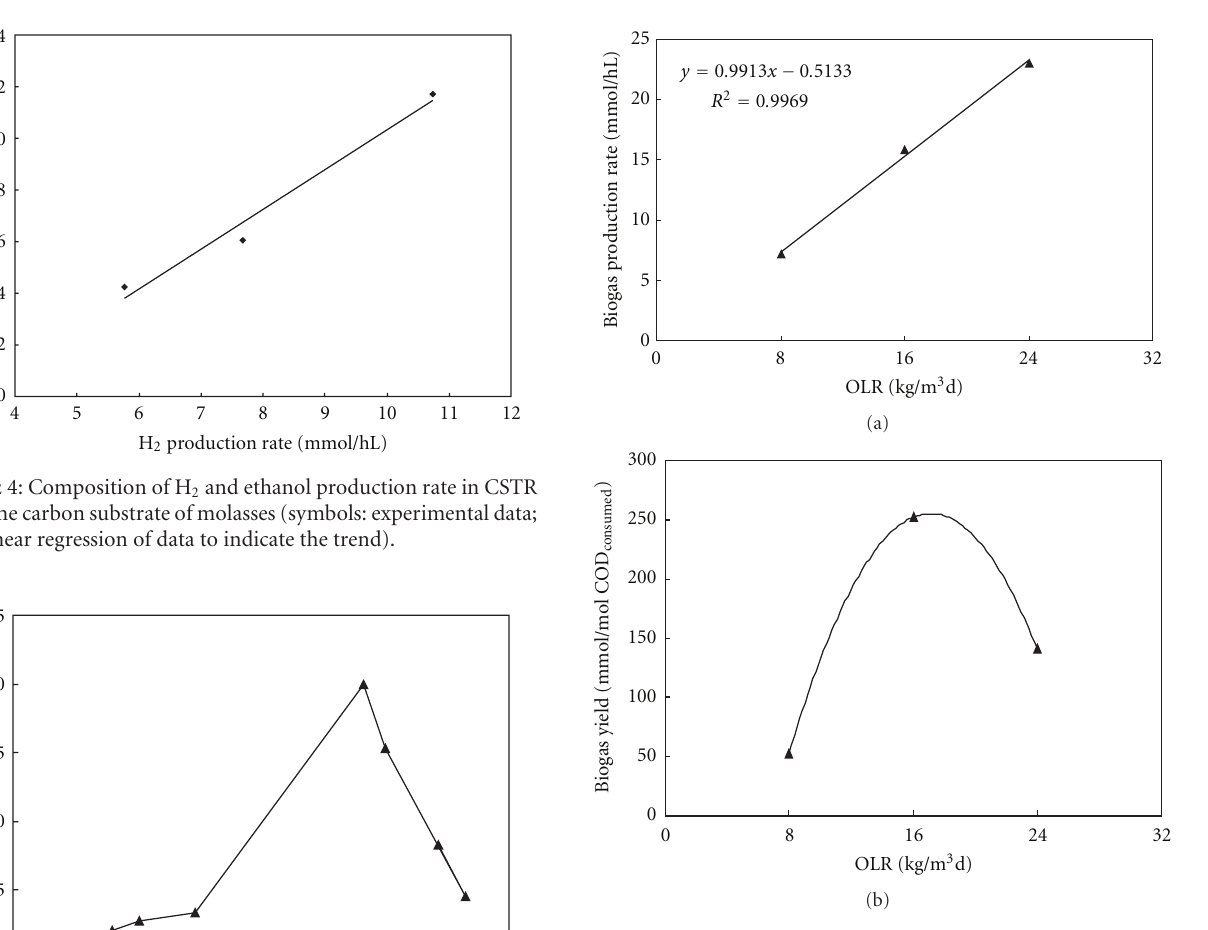
Figure 6: The performance of biogas production at di ff erent OLRs in the